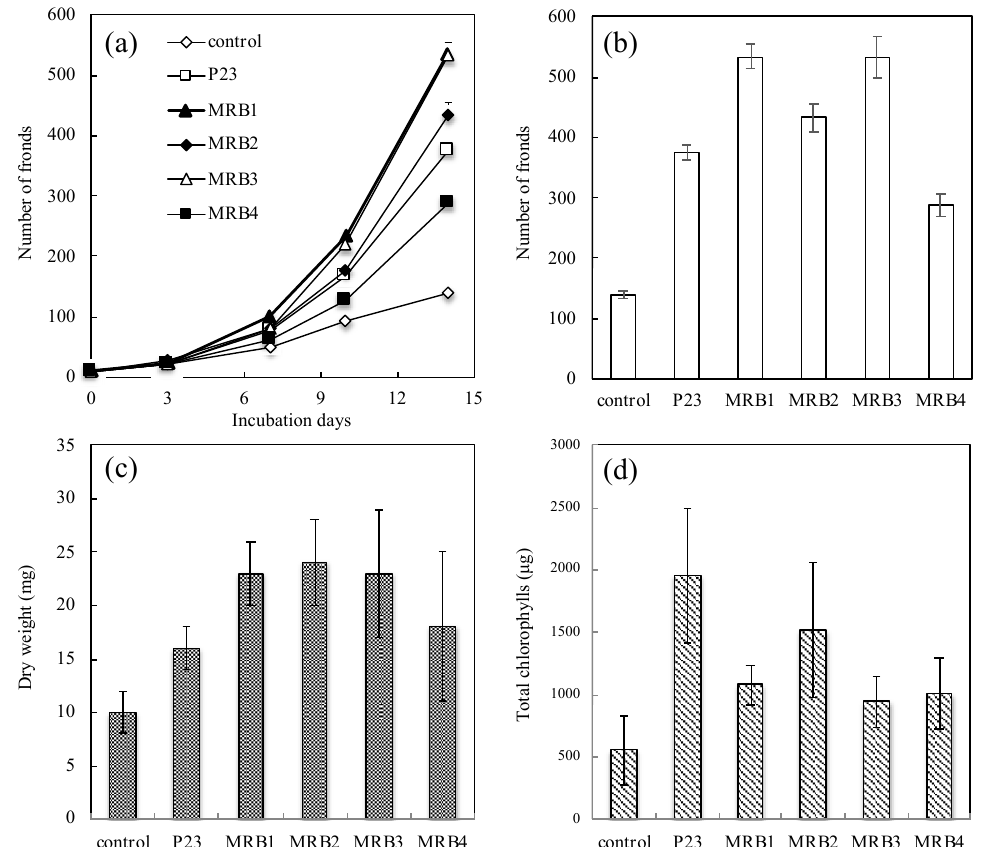
Figure 1. Symbiotic effects of the obtained strains MRB1–4 on the frond number, dry weight biomass, and chlorophyll content of duckweed ( Lemna minor ) after co-cultivation. The panels show changes in the ( a ) number of duckweed fronds over 14 days, ( b ) number and ( c ) dry weight biomass of duckweed fronds and ( d ) total chlorophyll content expressed as mg chlorophyll per 100 g frond dry weight after 14-day culture with no bacterial inoculation (labeled as control), Acinetobacter calcoaceticus P23, a known PGPB as a positive control strain (labeled as P23), and our strains MRB1–4. Each value represents the mean ± standard deviation (SD) of triplicate experiments.